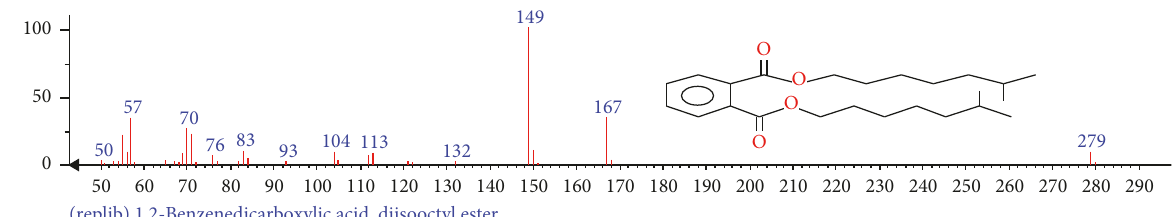
Figure 54: Mass spectrum of compound 1,2-benzenedicarboxylic acid, diisooctyl ester of whole plant hexane fraction of Achillea wilhelmsii